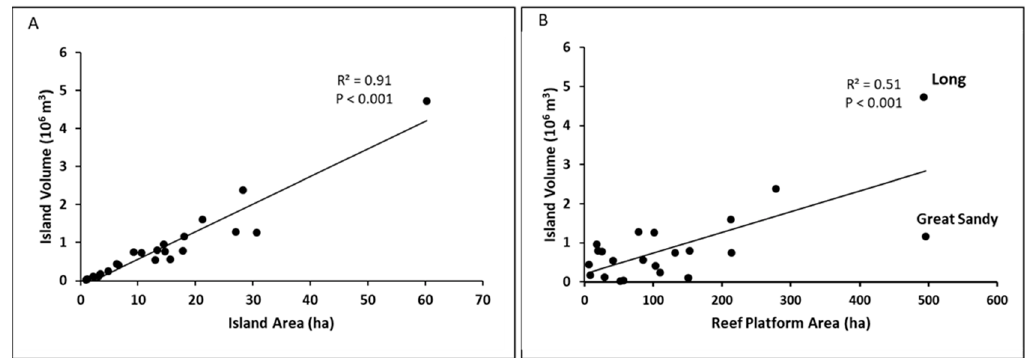
Figure 3. Linear regression of ( A ) island area versus island volume and ( B ) reef platform area vs. island volume for the 22 islands surveyed in October 2016.